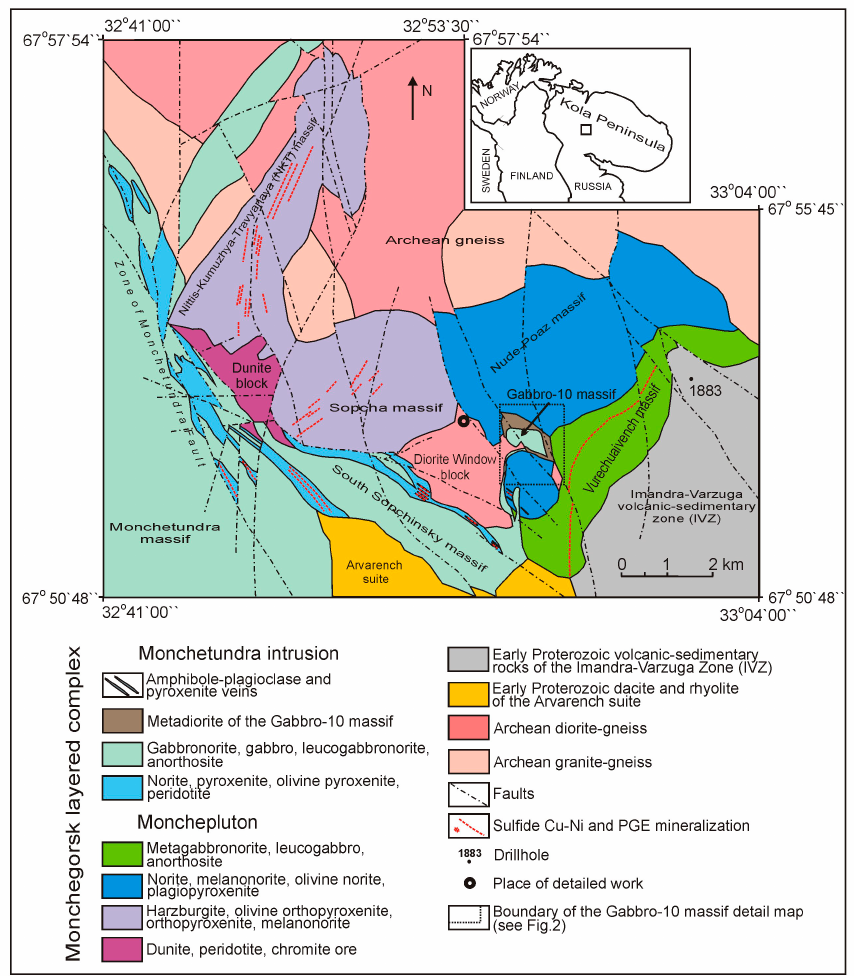
Figure 1. Geological map of the Monchegorsk complex.